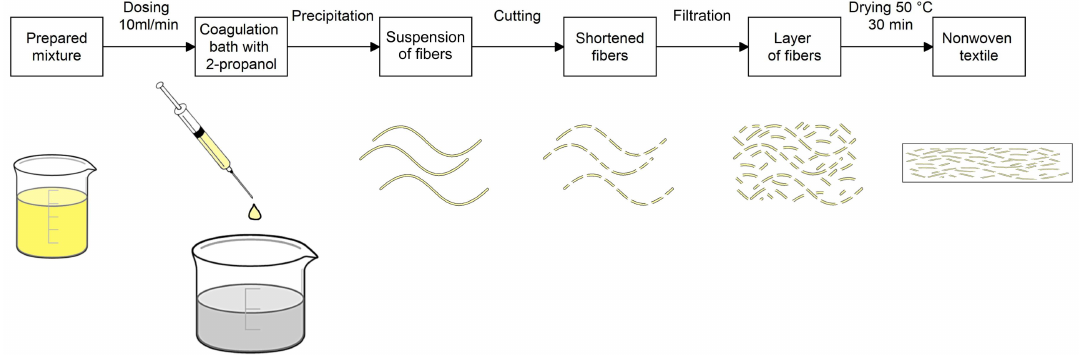
Figure 1. Schematic diagram illustrating the preparation of nonwoven textiles utilizing hyaluronic acid and cellulose.